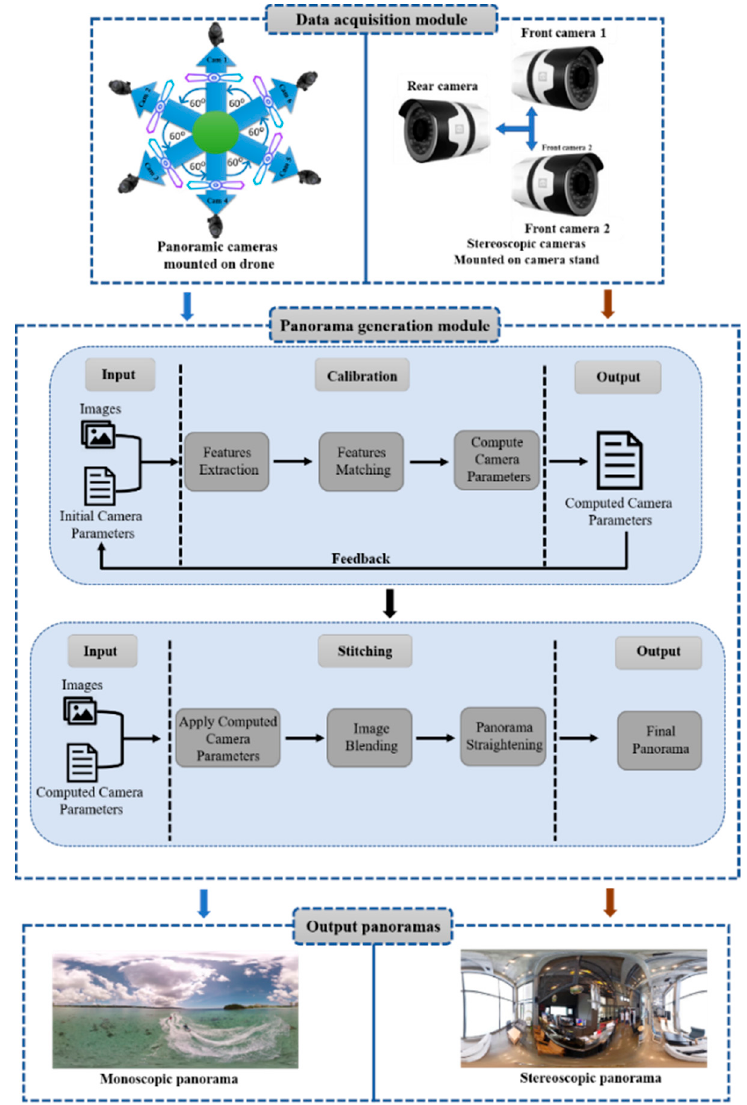
Figure 1. A detailed overview of the proposed panorama generation framework. The proposed framework involves two main steps including data acquisition and panorama generation